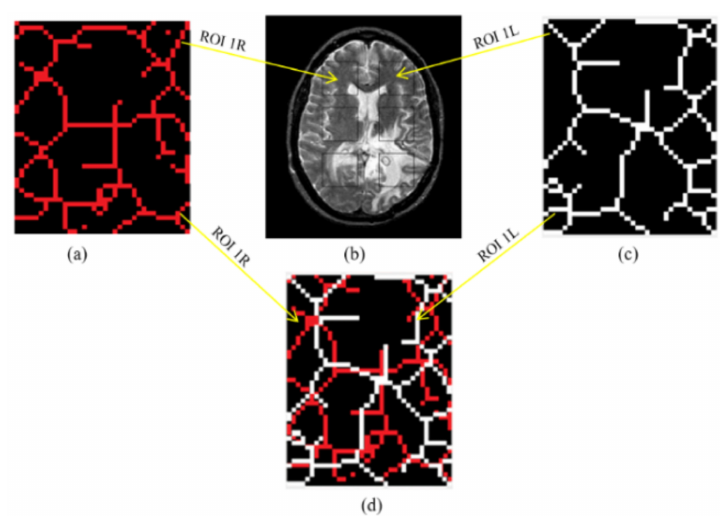
Figure 4. (a ) Skeletal map of ROI 1R; ( b ) rectangular masks overlaid on a T2w MRI image for a patient diagnosed with glioma; ( c ) Skeletal map of ROI 1L; ( d ) ROI 1R, and ROI 1L overlapped to highlight di ff erences between the skeletal maps.